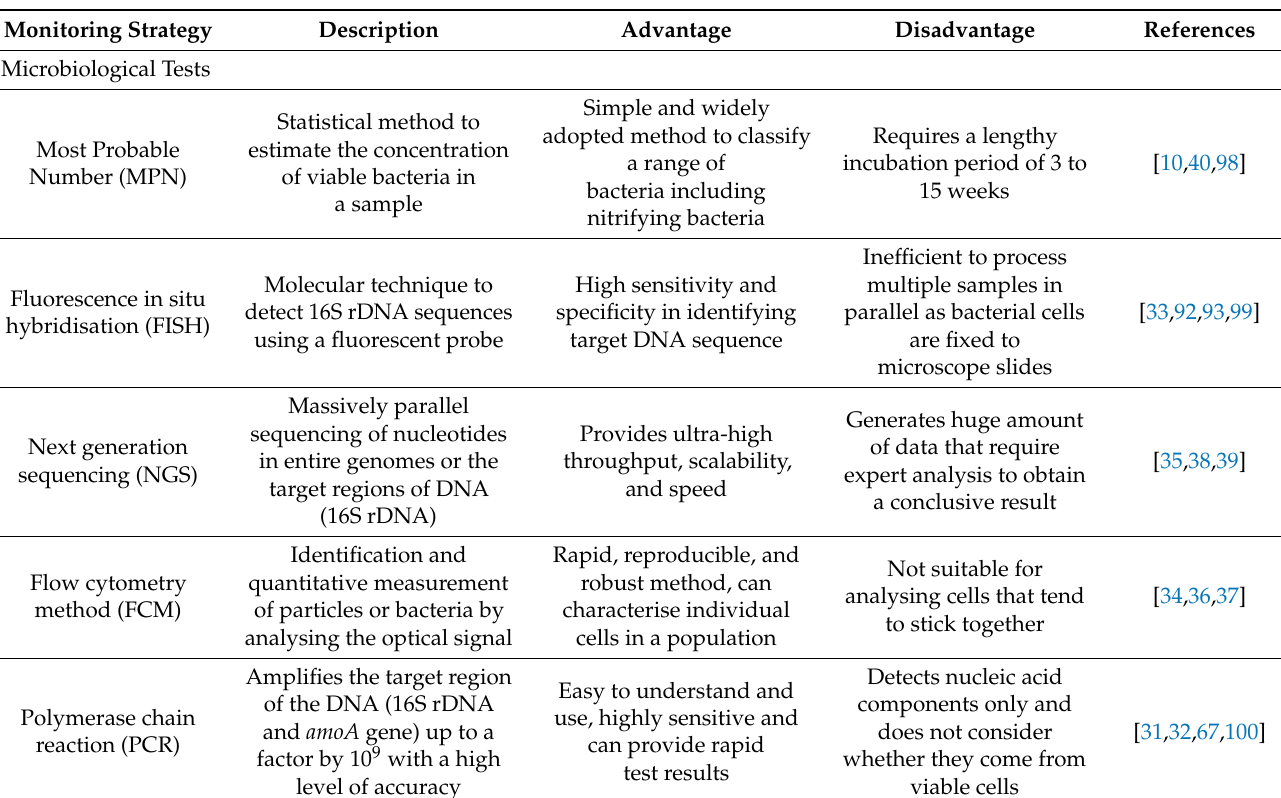
Table 4. Summary of nitrification monitoring strategies in